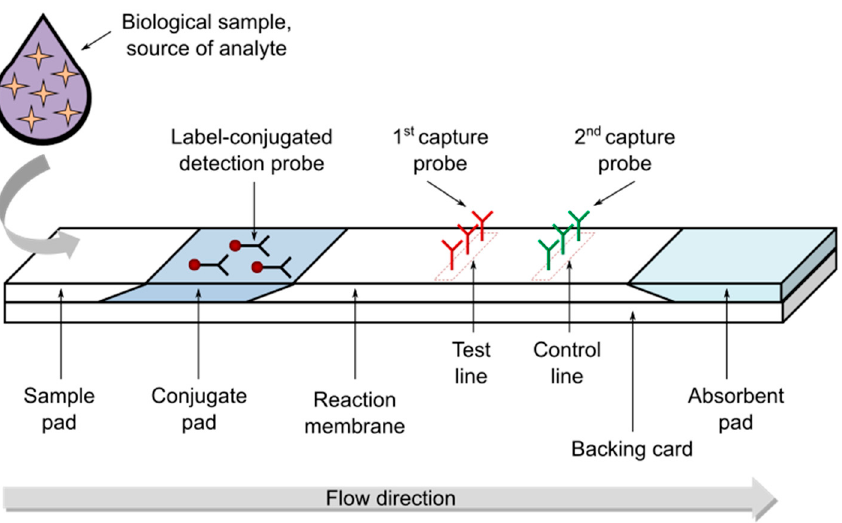
Figure 1. Illustration of a typical lateral flow test (LFT) strip.